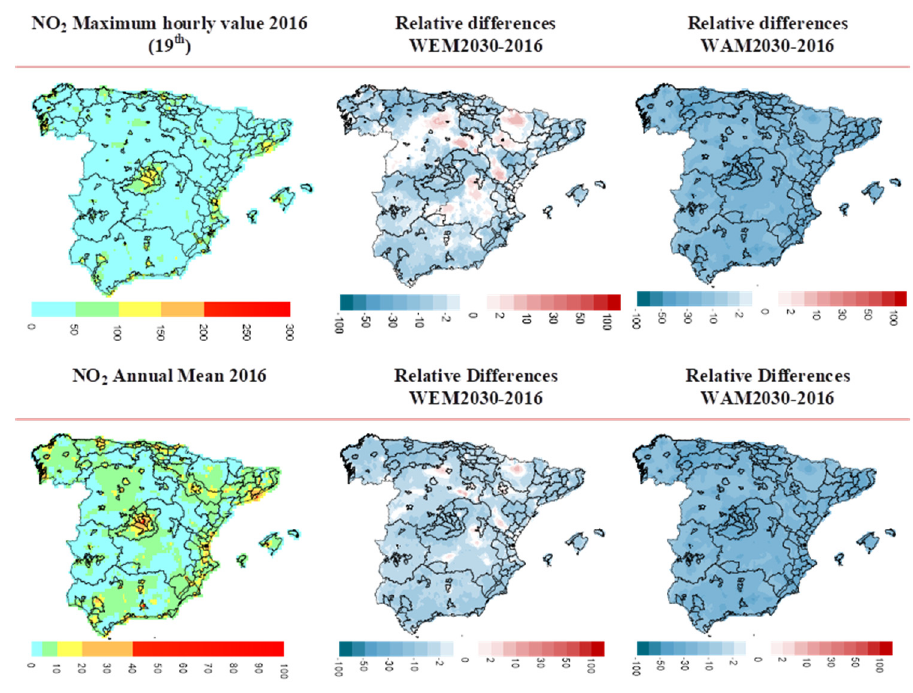
Figure 4. Concentration maps ( µ g m − 3 ) showing the 19th highest hourly values of NO 2 ( top row, Figure 5. Concentration maps showing the 19th highest hourly values of NO2 (top row) and the 207 left) and the annual mean ( bottom row, left) in 2016. Maps on the middle and right show the relative annual mean (bottom row). Maps on the left show the concentration in 2016 and relative differences 208 differences (%) with respect to 2016 for the WEM2030 (middle) and WAM2030 (right) (%) with respect to 2016 are shown for the WEM2030 scenario (middle) and WAM2030 (right). 209